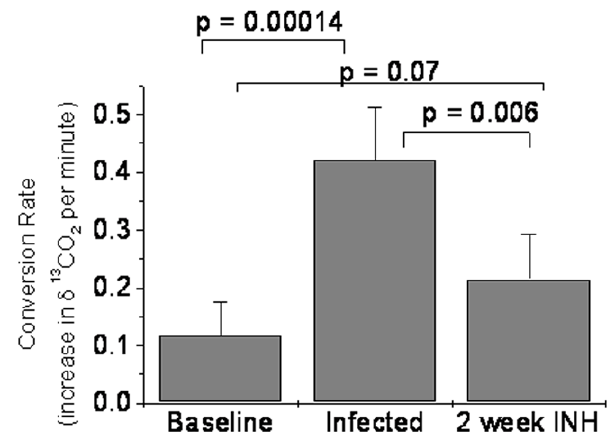
Figure 5. Mean conversion rates of [ 13 C]-urea per minute among M. tuberculosis H37Rv and M. bovis -infected rabbits. Repeated measurements had occurred of each breath test sample. Significant conversion rate differences are noted after both infection and treatment with 25mg/kg of INH. Rates were obtained prior to infection, 4–8 weeks after bronchoscopic infection and within two weeks post-INH treatment.